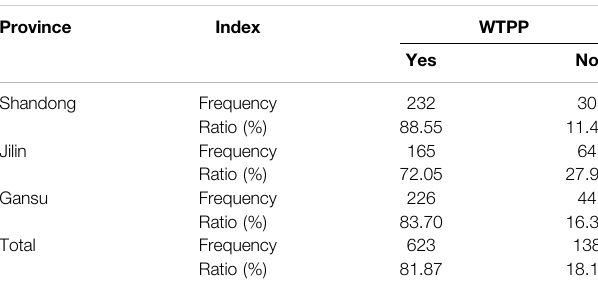
TABLE 2 | Farmers ’ WTPP for the CMP of RDST.